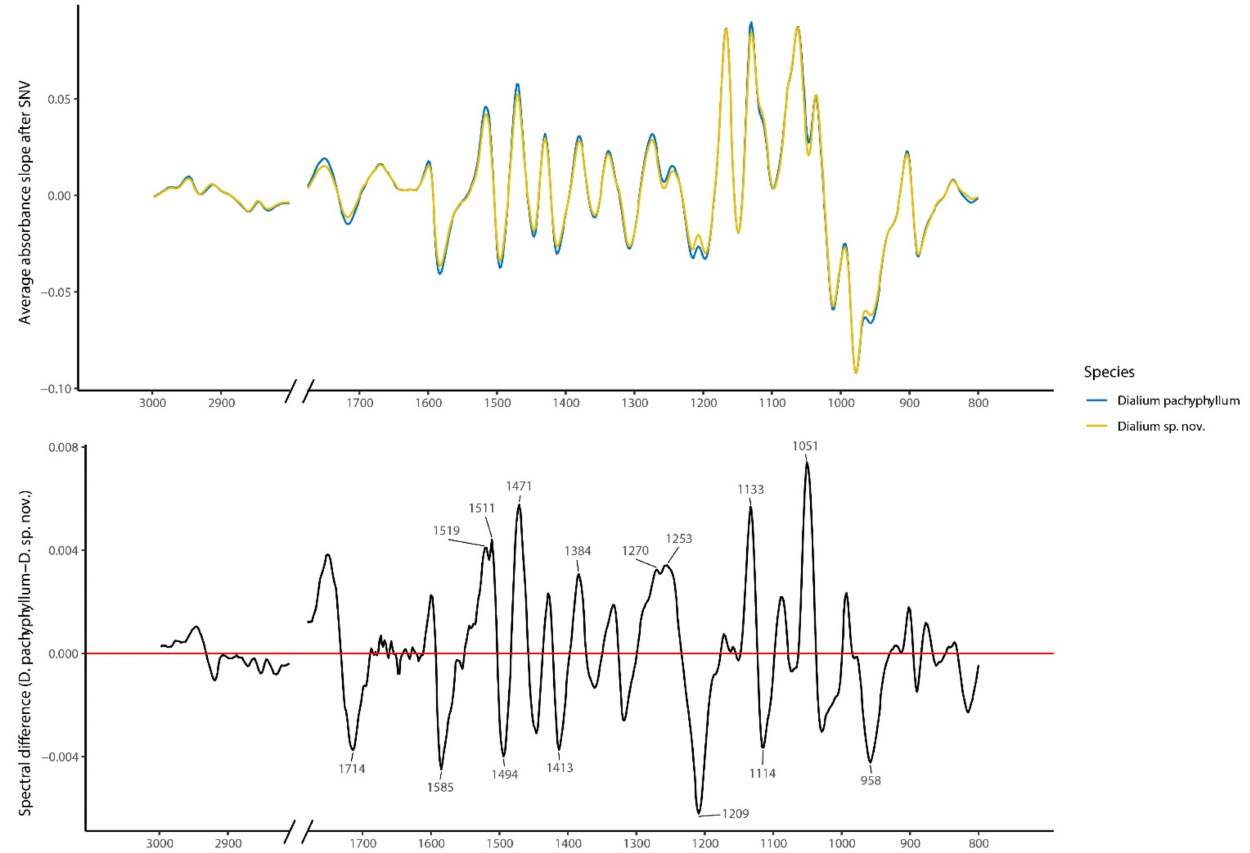
Figure 6. Upper plot presents average preprocessed (SNV + first derivatitive) spectrum of each species. The lower graph represents the difference ( D. pachyphyllum - D. sp. nov.) between the average spectra. The 15 wavenumbers correspond to 15 high peaks of difference between the